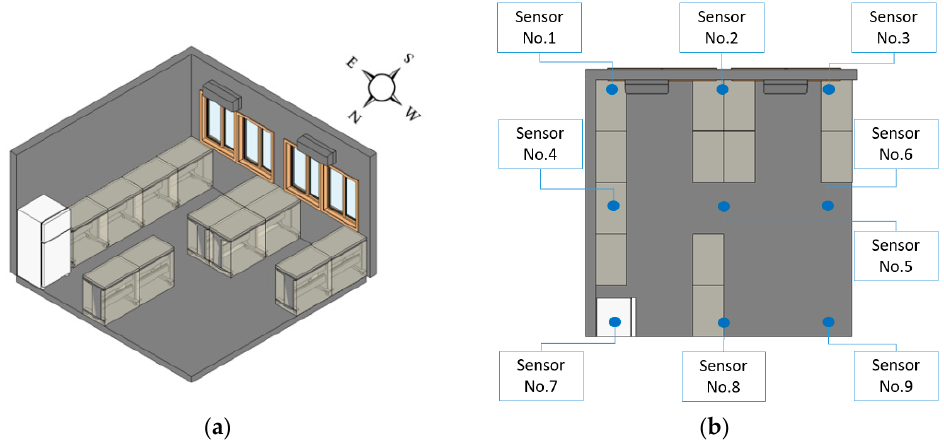
Figure 14. ( a ) Spatial layout of the research laboratory; ( b ) sensor locations.